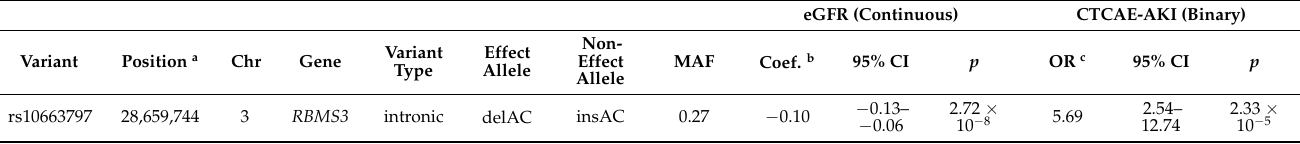
Table 3. Results of genome-wide significant variant from creatinine-based GWAS.